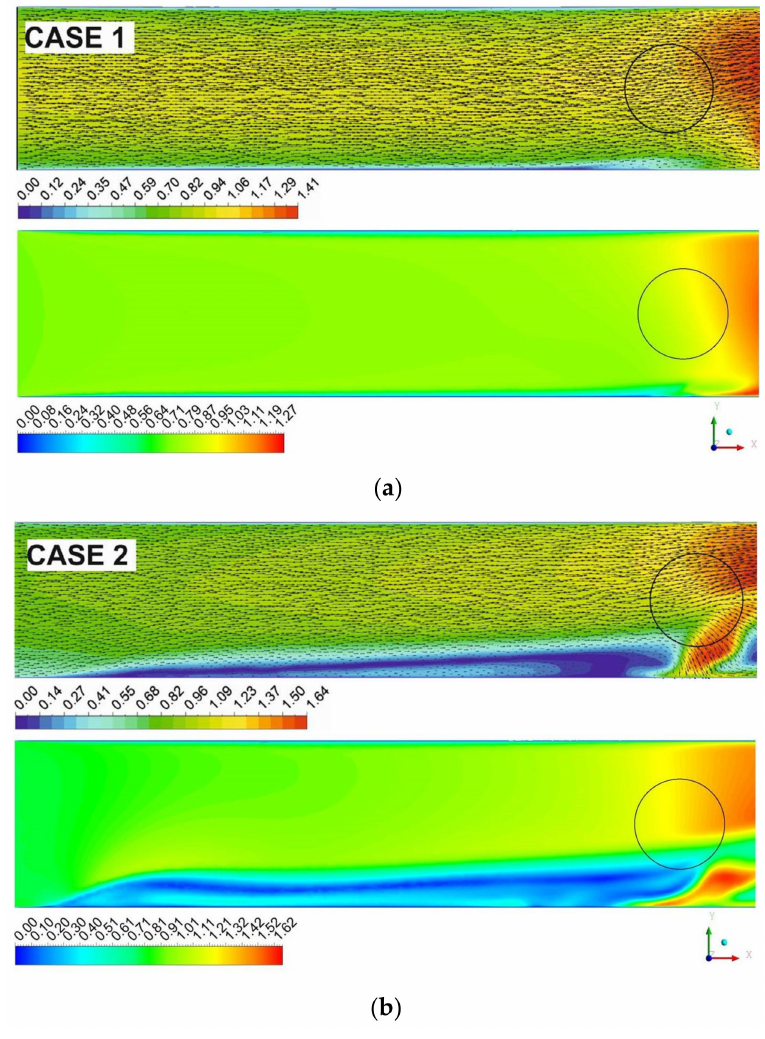
Figure 11. Distribution of the dimensionless velocity U * in the middle plane of the T-junction (black circle—inlet opening of the socket): ( a )—ST1, Table 2 (top figure—LES results [12], bottom figure—RANS results); ( b )—ST2, Table 2 (top figure—LES results [12], bottom figure—RANS